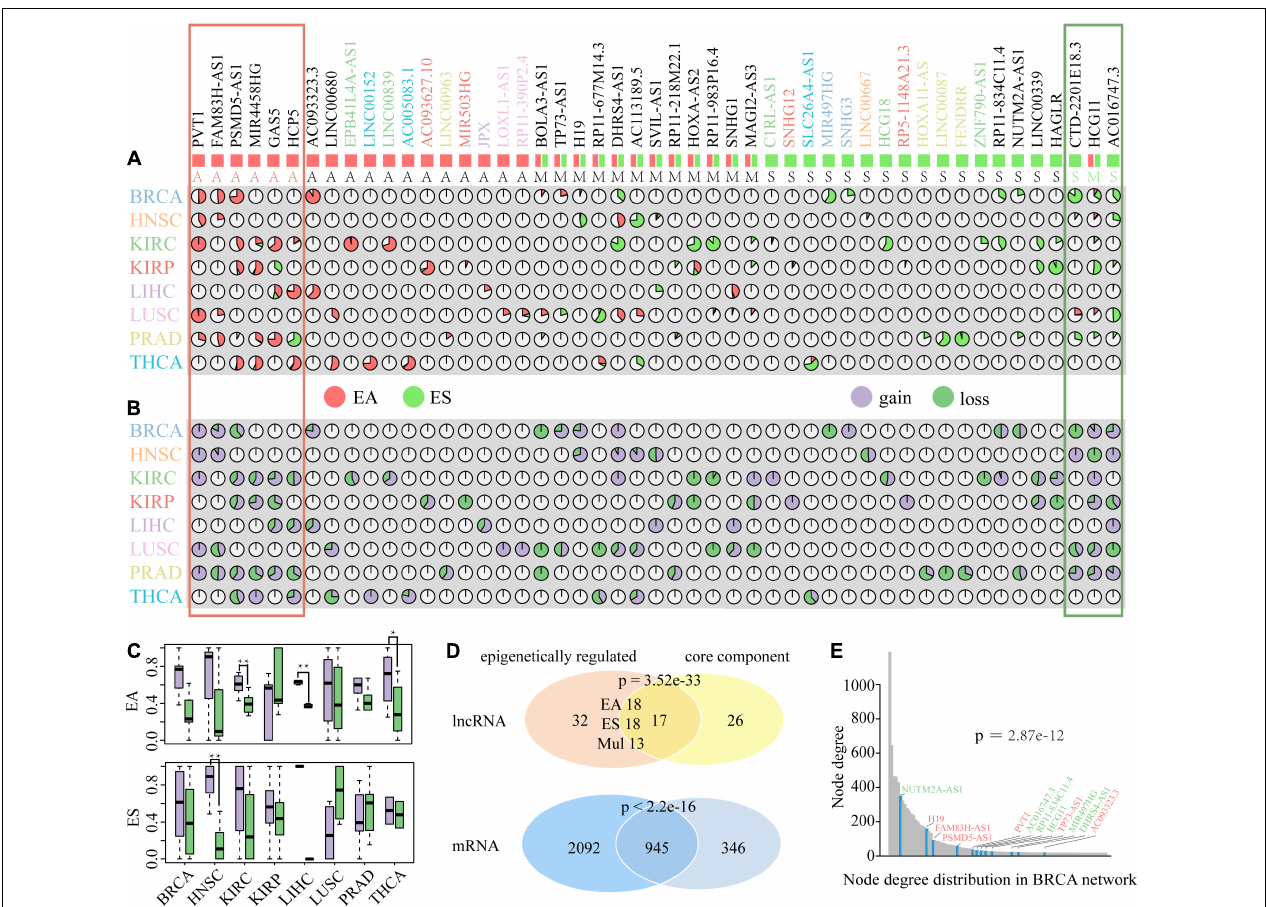
FIGURE 5 | The distribution and attribute of ER lncRNAs in DysCeNets. (A) Percentages of EA and ES lncRNAs in eight cancer types. Each pie chart indicates the percentage of each lncRNA epigenetic alteration in each cancer type. Red indicates EA lncRNAs, and green indicates ES lncRNAs. The symbol of lncRNAs with special color represents the lncRNA altered in a specific cancer type. Symbols below with A represented EA lncRNAs, S represented ES lncRNAs, and M represented multi-ER lncRNAs. The red frame represents the lncRNAs epigenetically activated in pan-cancer, and the green frame represents the lncRNAs epigenetically silenced in pan-cancer. (B) The property of edges linked to ER lncRNAs in DysCeNets. Each pie chart indicates the percentage of dysregulated status. Purple indicates gain interaction, and green indicates loss interaction. (C) The property of edge linked to EA and ES lncRNAs in DysCeNets. ** P -value < 0.05, * P -value < 0.1. (D) The comparison of lncRNAs and related mRNAs between epigenetically related ceRNAs and core component. (E) The node degree distribution of top 100 ceRNAs in BRCA DysCeNet. The blue column represents the node degree of ER lncRNAs. The symbol colored red represents EA lncRNAs, and the symbol colored green represents ES